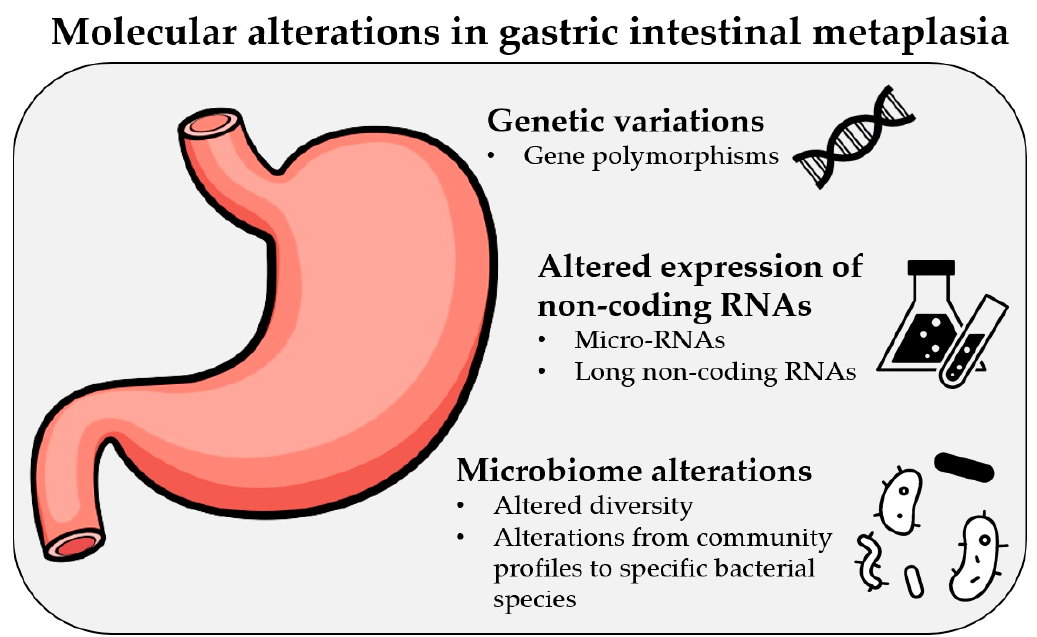
Figure 2. Most frequent molecular alterations observed in gastric intestinal metaplasia.